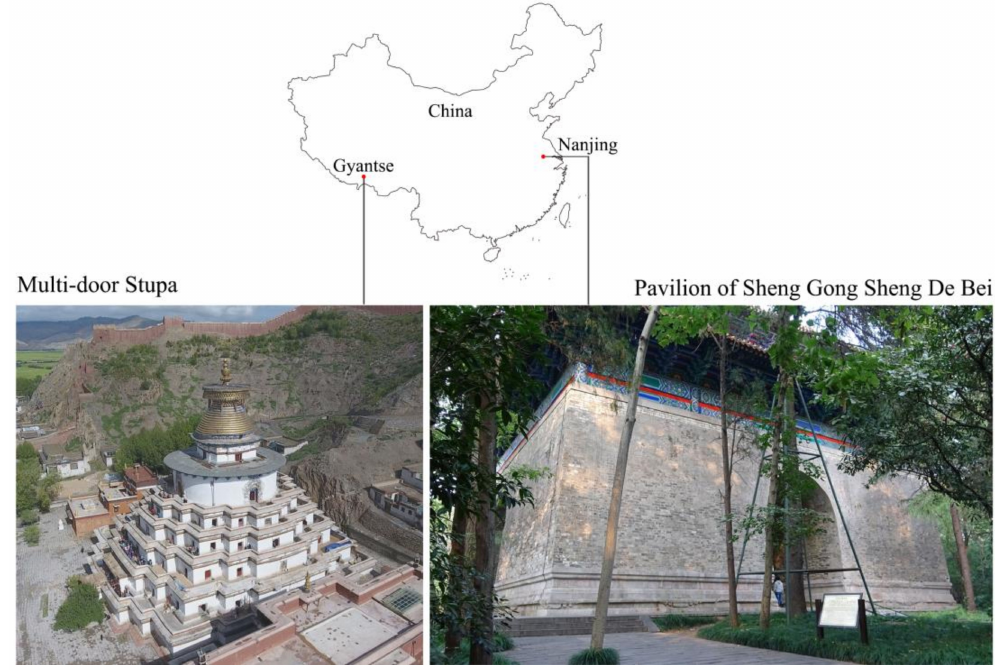
Figure 2. The two surveyed narrow